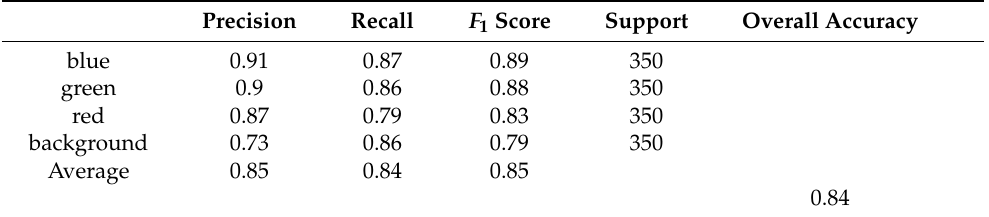
Table 2. RF performance